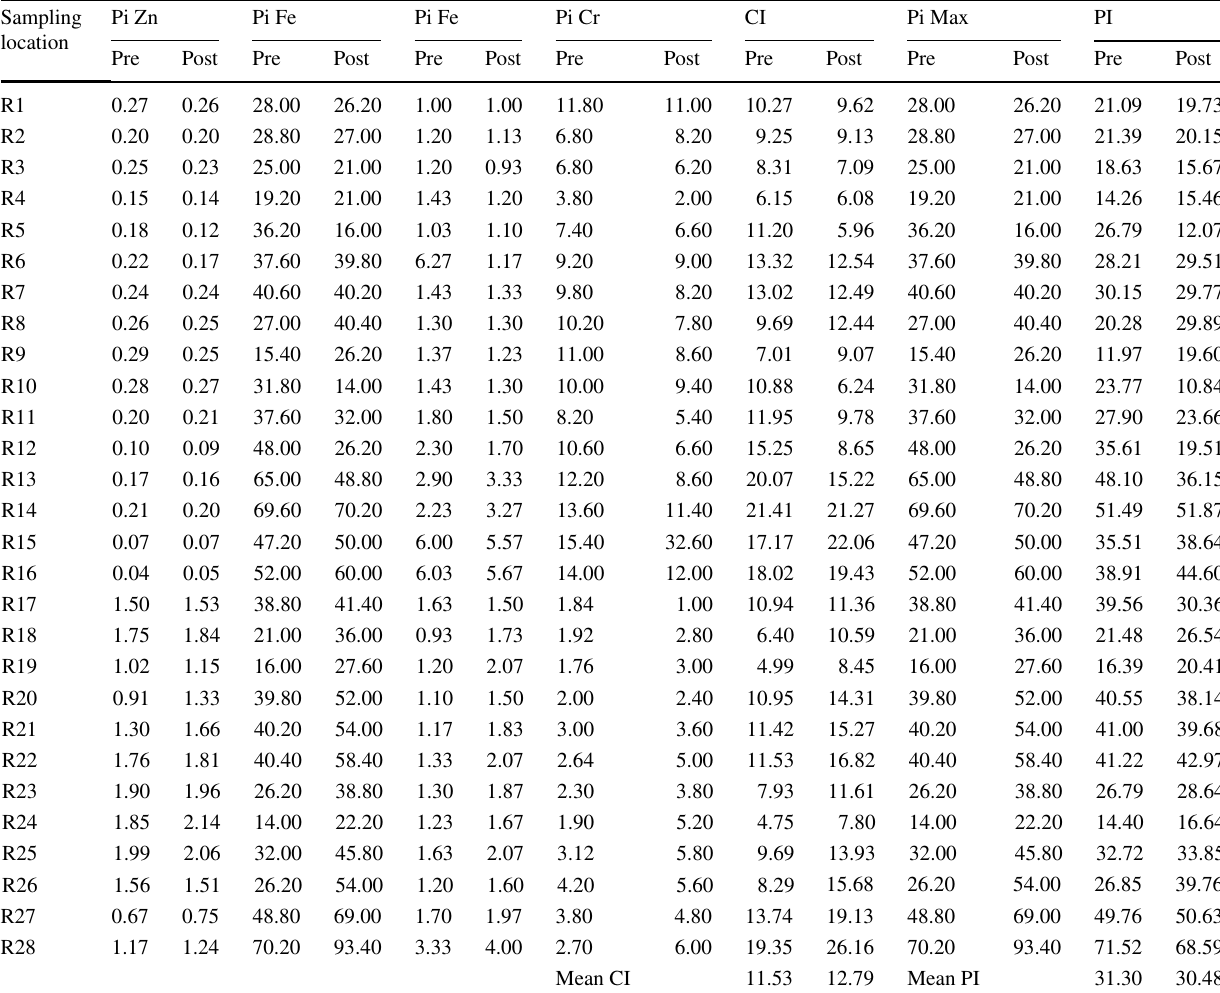
Table 2 Evaluation of CI and PI during pre- and post-monsoon months (2013–14) Sampling location